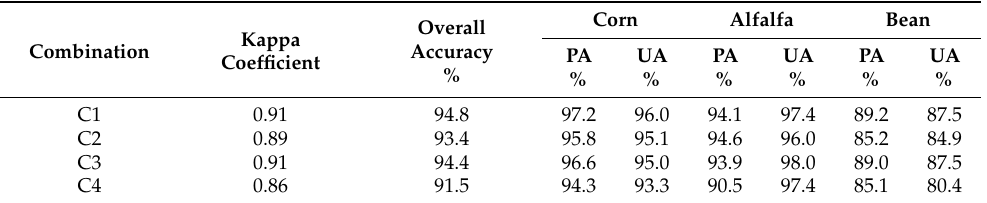
Accuracy assessment obtained in each of the crop recognition models with the SVM